Question: Which kind of chart has been used to present this data?
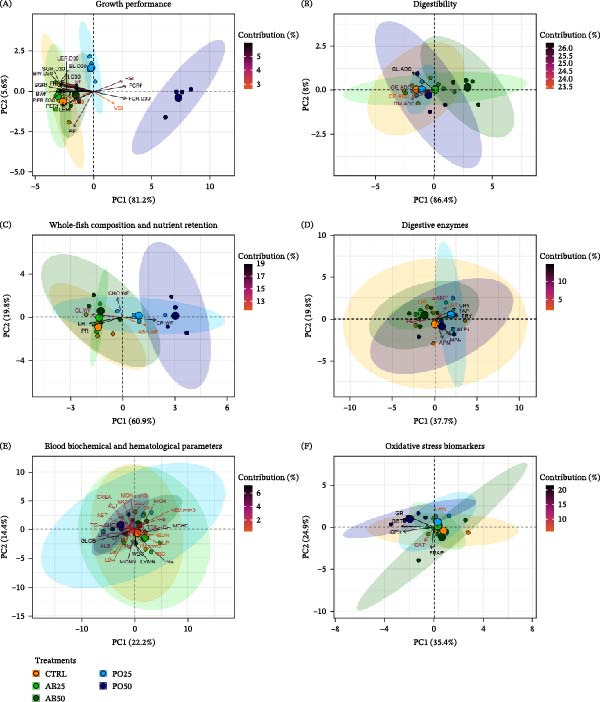
Answer: scatter